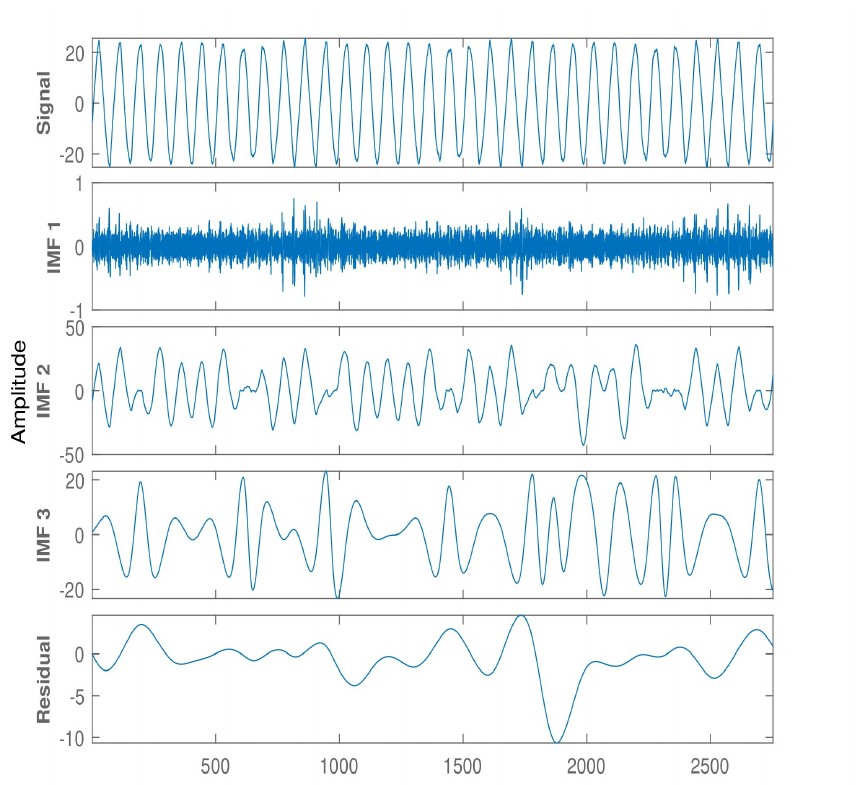
Figure 5. Empirical mode decomposition with one rotor bar